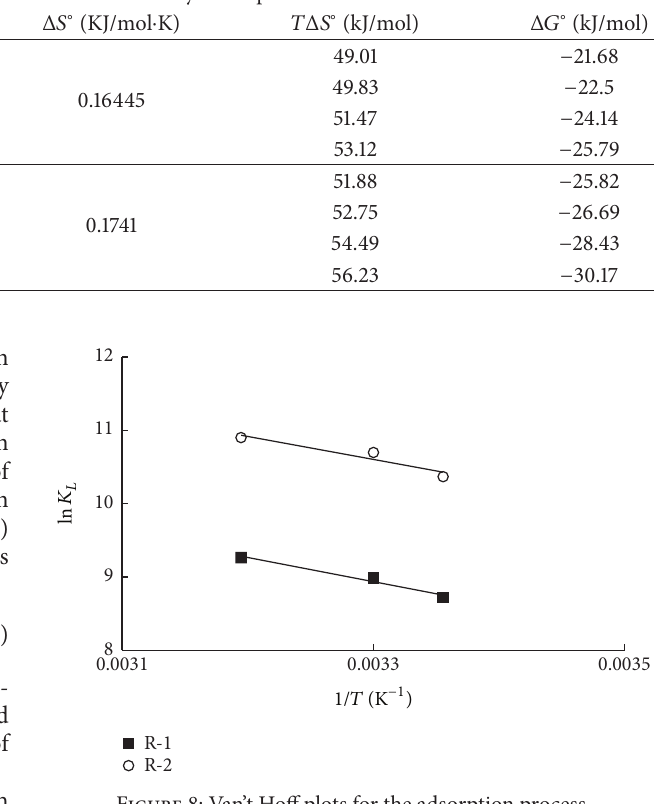
Figure 8: Van’t Hoff plots for the adsorption